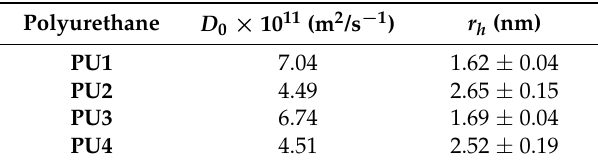
Table 3. The measured average values of D 0 for the PUs determined by PGSE NMR and